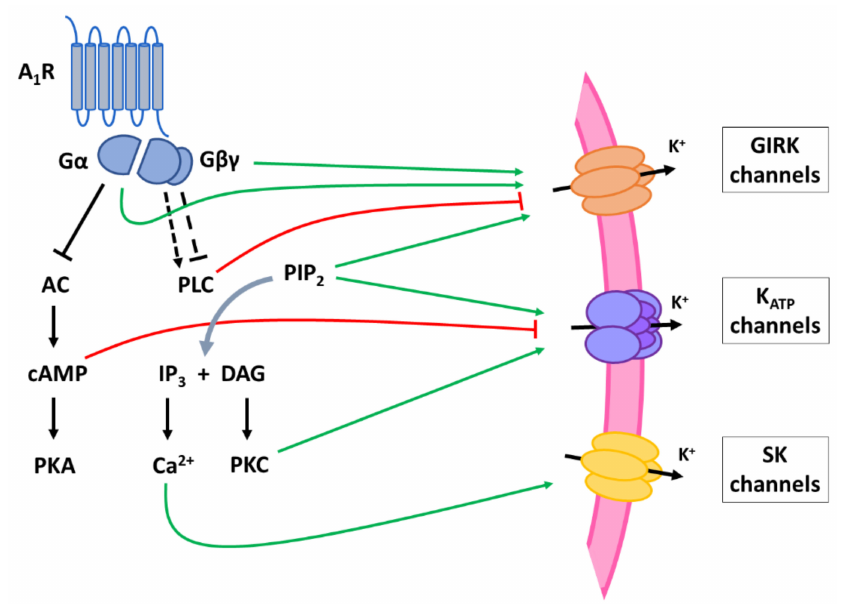
Figure 3. Schematic representation of the signaling pathways involved in increased K + permeability and hyperpolarizing effects of A 1 R activation. A 1 Rs activate G protein-coupled inwardly rectifying K + (GIRK) channels directly via the G protein subunits (G α and G βγ ) or indirectly by inhibiting PLC activity. A 1 Rs increase ATP-sensitive K + (K ATP ) channel activity by inhibiting the AC/cAMP pathway or by both stimulating (via increased PKC) or inhibiting (via increased PIP 2 ) the PLC pathway. A 1 R- induced IP 3 stimulation activates small conductance Ca 2+ -activated K + (SK) channels by increasing intracellular Ca 2+ concentration. The pathway underlying activation of two-pore domain K + (K2P) channels is unknown and therefore not presented here. AC: adenyl cyclase; cAMP: cyclic adenosine monophosphate; PKA: protein kinase A; PLC: phospholipase C; PIP 2 : phosphatidylinositol 4,5- bisphosphate; IP 3 : inositol 1,4,5-trisphosphate; DAG: diacylglycerol; PKC: phosphokinase